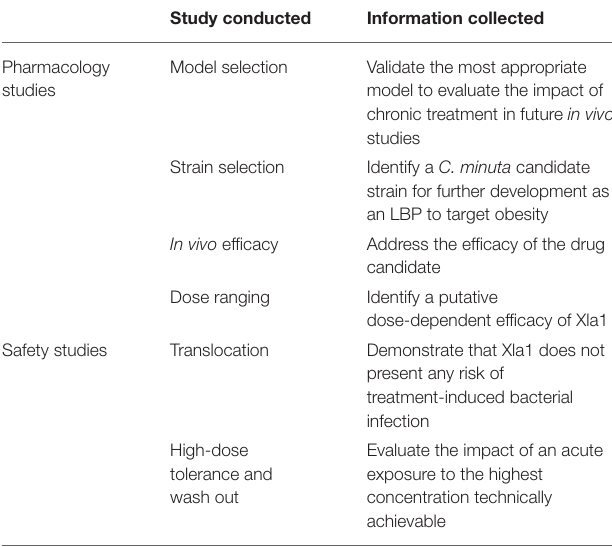
TABLE 3 | Non-clinical package proposed for